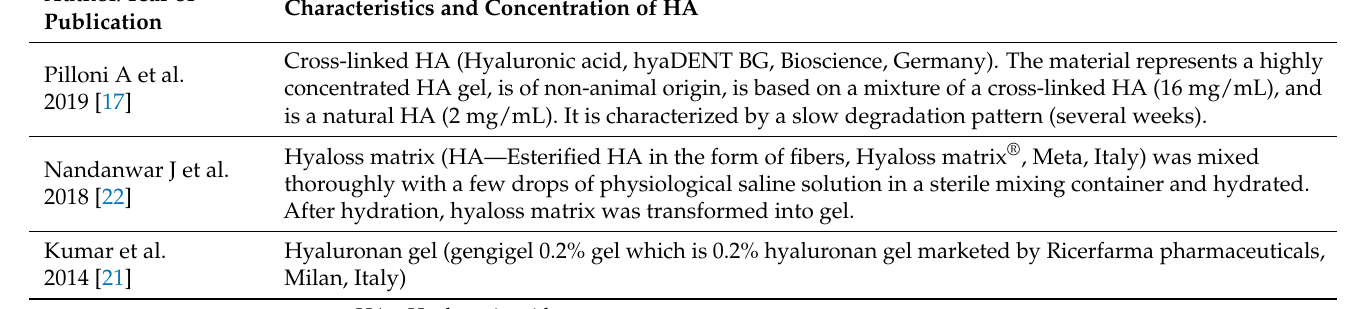
Table 4. Characteristics and Concentration of